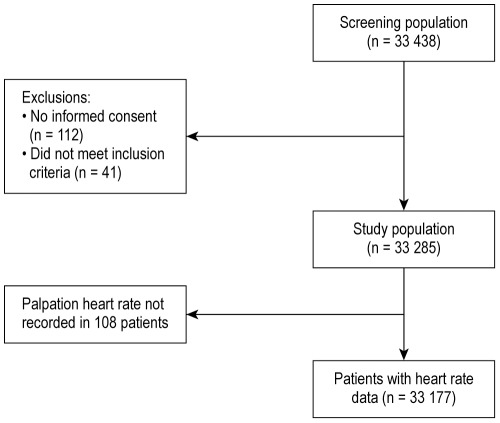
Patient flow chart.